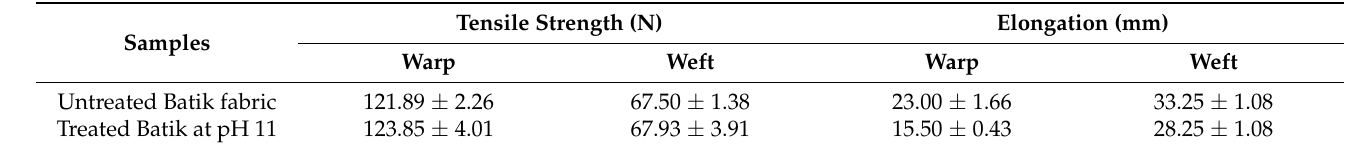
Table 4. The mechanical properties of untreated and treated Batik fabric.